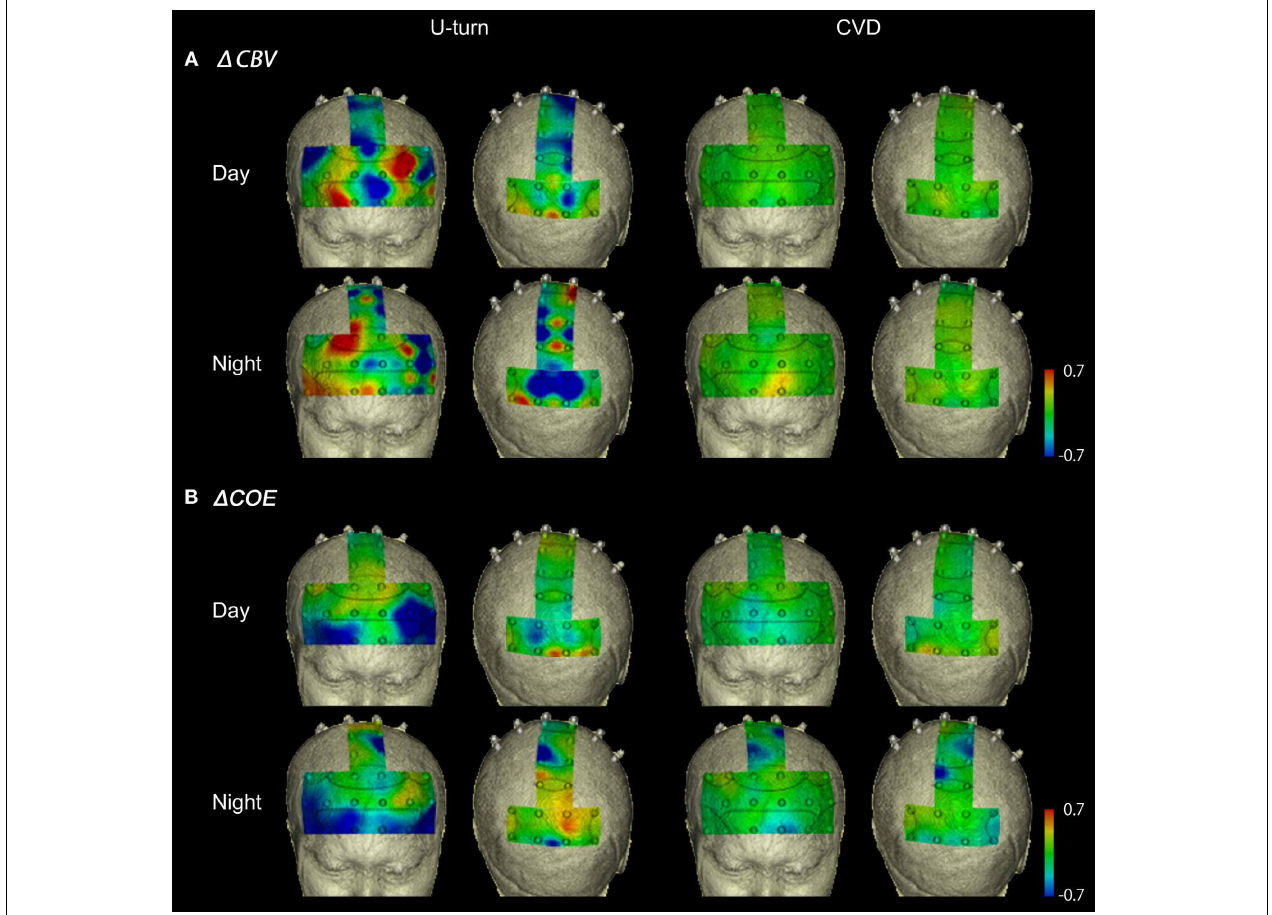
FIGURE 7 | Functional neuroimages of (cid:2) CBV (A) and (cid:2) COE (B) during U-turns and